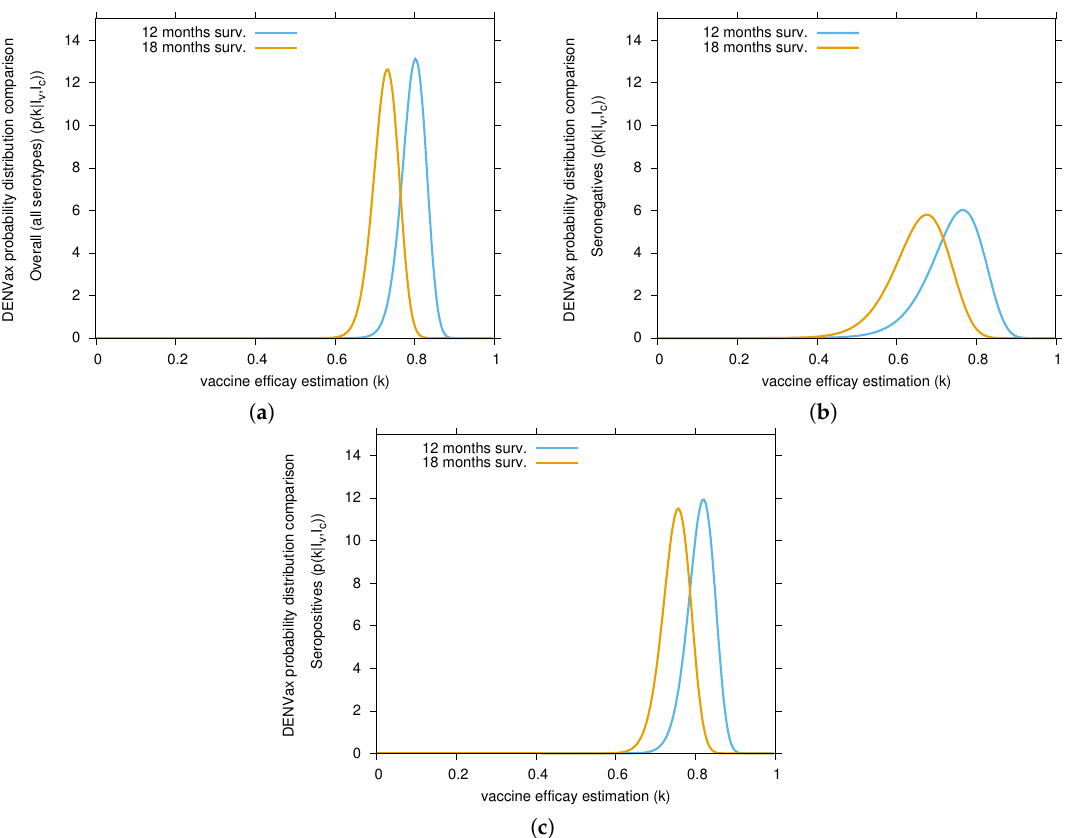
Figure 2. Bayesian estimates comparison of DENVax vaccine efficacies (VE) against virologically confirmed dengue cases. Yellow and light blue curves show the estimates for the first 12 months (part 1) and the 18 months (part 2) surveillance, respectively. In ( a ) overall VE estimations for all serotypes, in ( b ) VE estimation for seronegative individuals and in ( c ) VE estimations for seropositive individuals. Data from Tables 1 and 2, in good agreement with results reported in [9,10], are used to estimate the distribution by dengue serotype and serostatus for individuals aged 4–16 years old. Vaccine efficacy is decreasing over